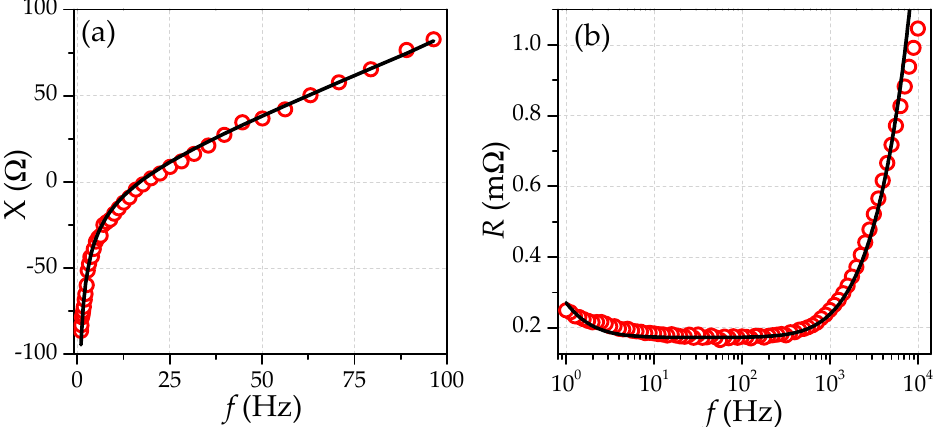
Figure 7. Simulated and measured EIS data of symmetric double-layer UC ( a ) reactance, ( b ) resistance.